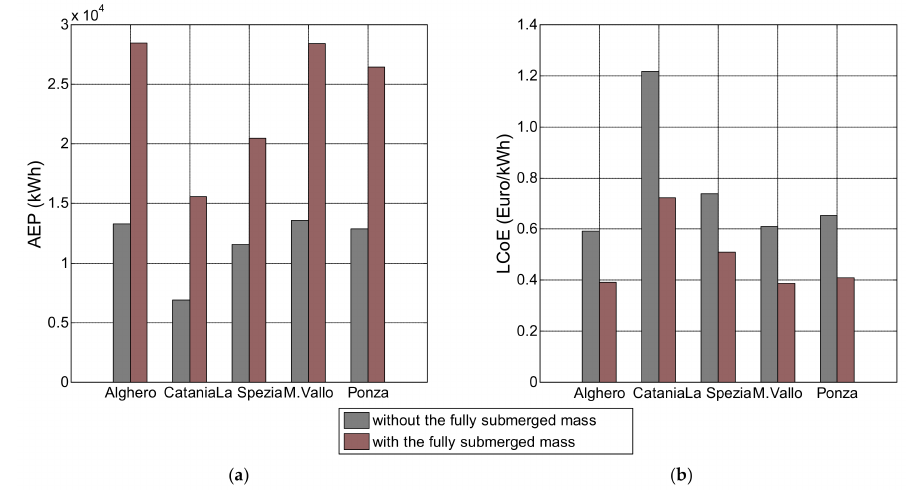
Figure 6. Comparative analysis among optimum WEC configurations. ( a ) AEP at candidate deployment sites; ( b ) LCoE at candidate deployment sites.